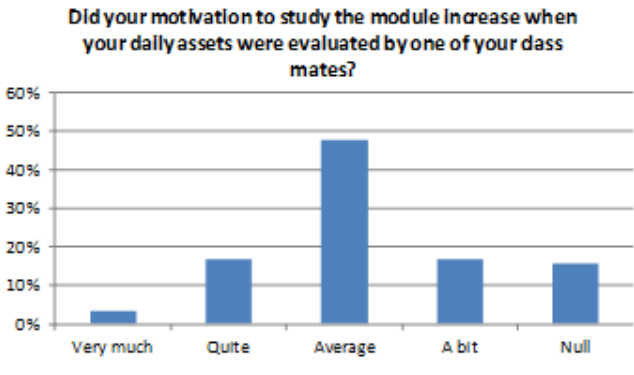
Figure 12. Opinion of the students on the influence of